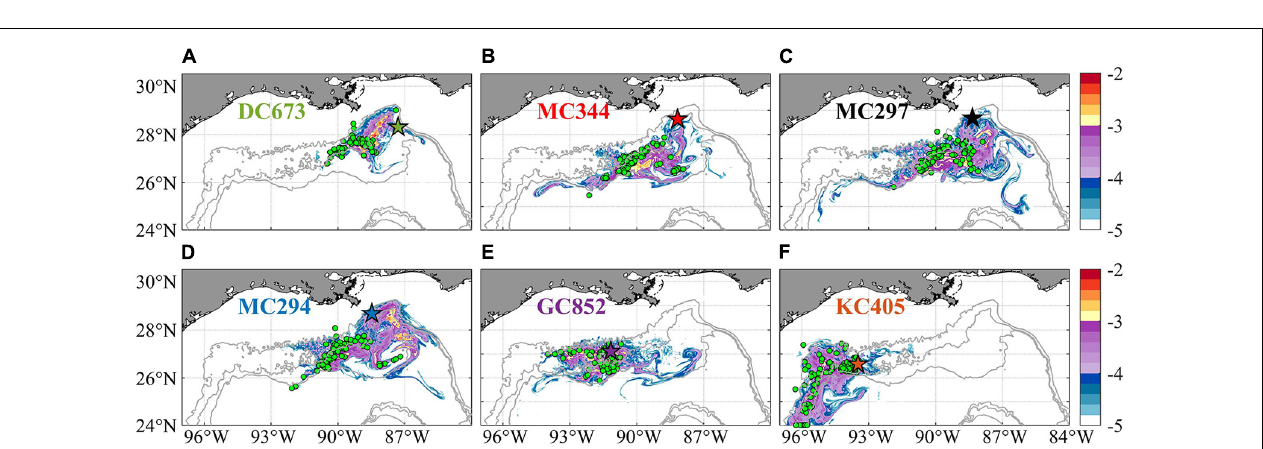
FIGURE 10 | Horizontal kernel density estimation (KDE) pattern of particle locations after 148 days tracking in November without (A) and with (B) extra vertical diffusion (colors indicate probability values). A comparison of the probability density function (PDF) of the depth of particles released at each location is shown in panel (C) . Solid/dash line indicates without/with vertical diffusion. All available particles are retained to show a thorough comparison.